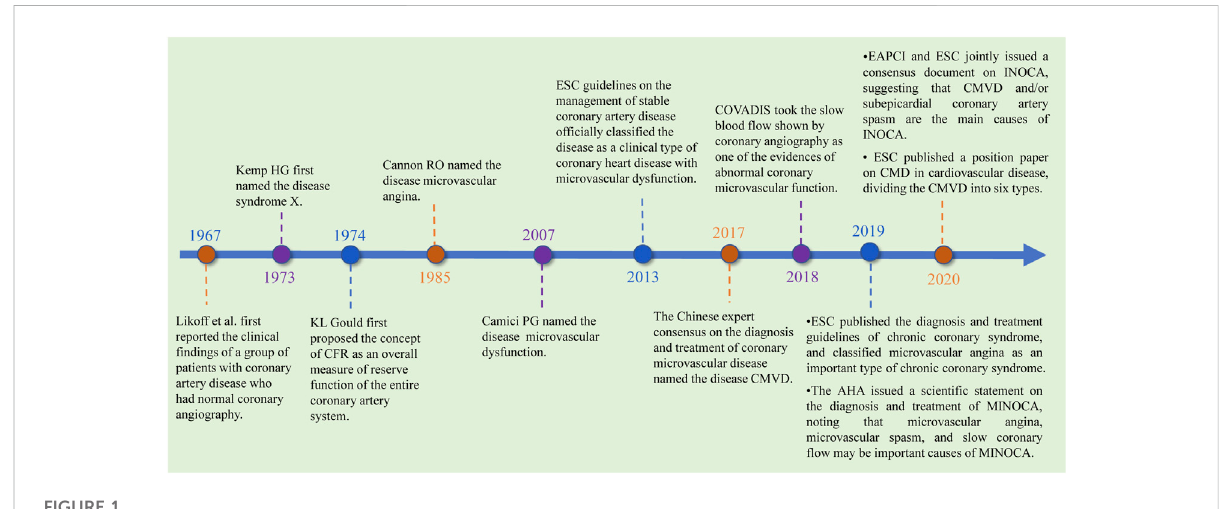
FIGURE 1 Development and research progress of